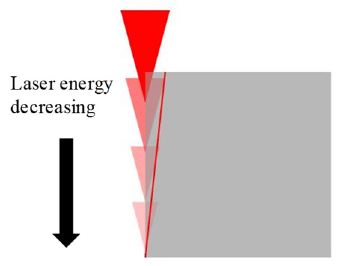
Figure 15. Schematic diagram of the laser shielding effect.